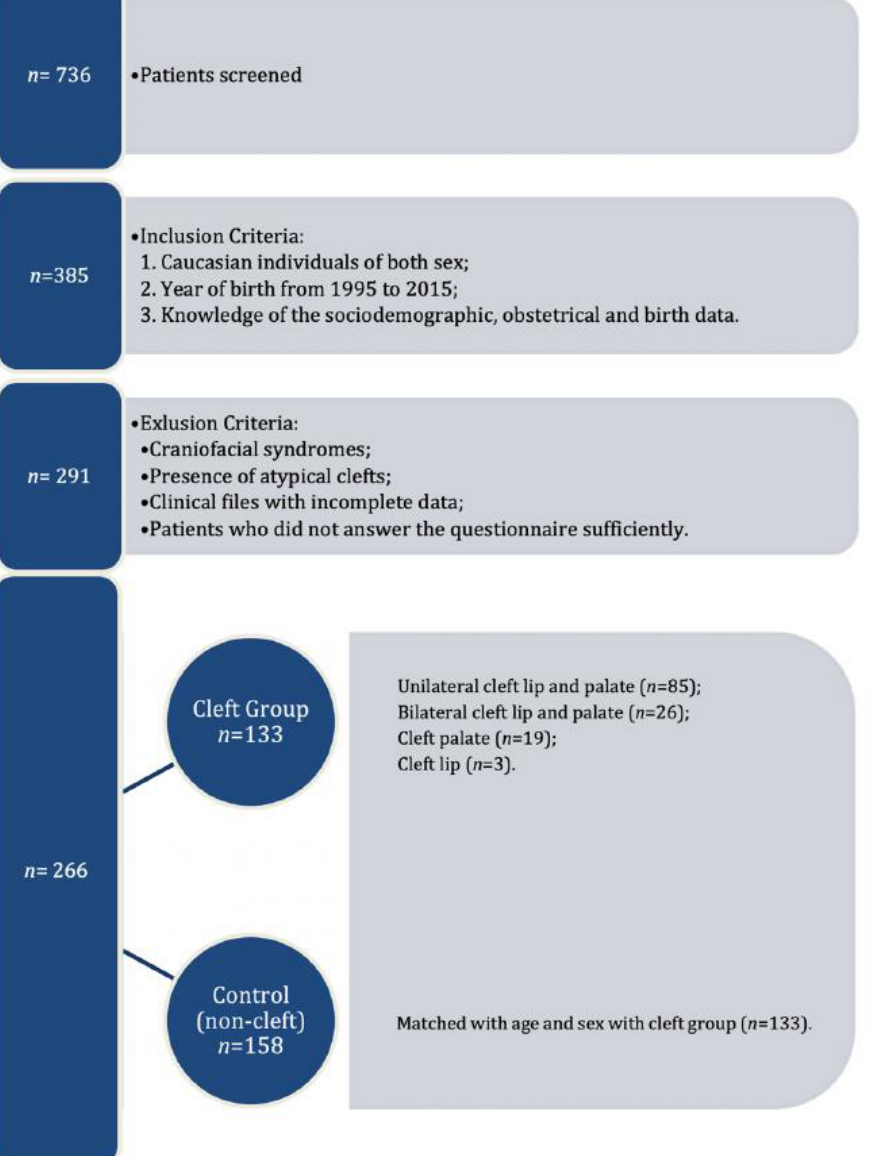
Figure 1. Flow chart of the inclusion and exclusion criteria.